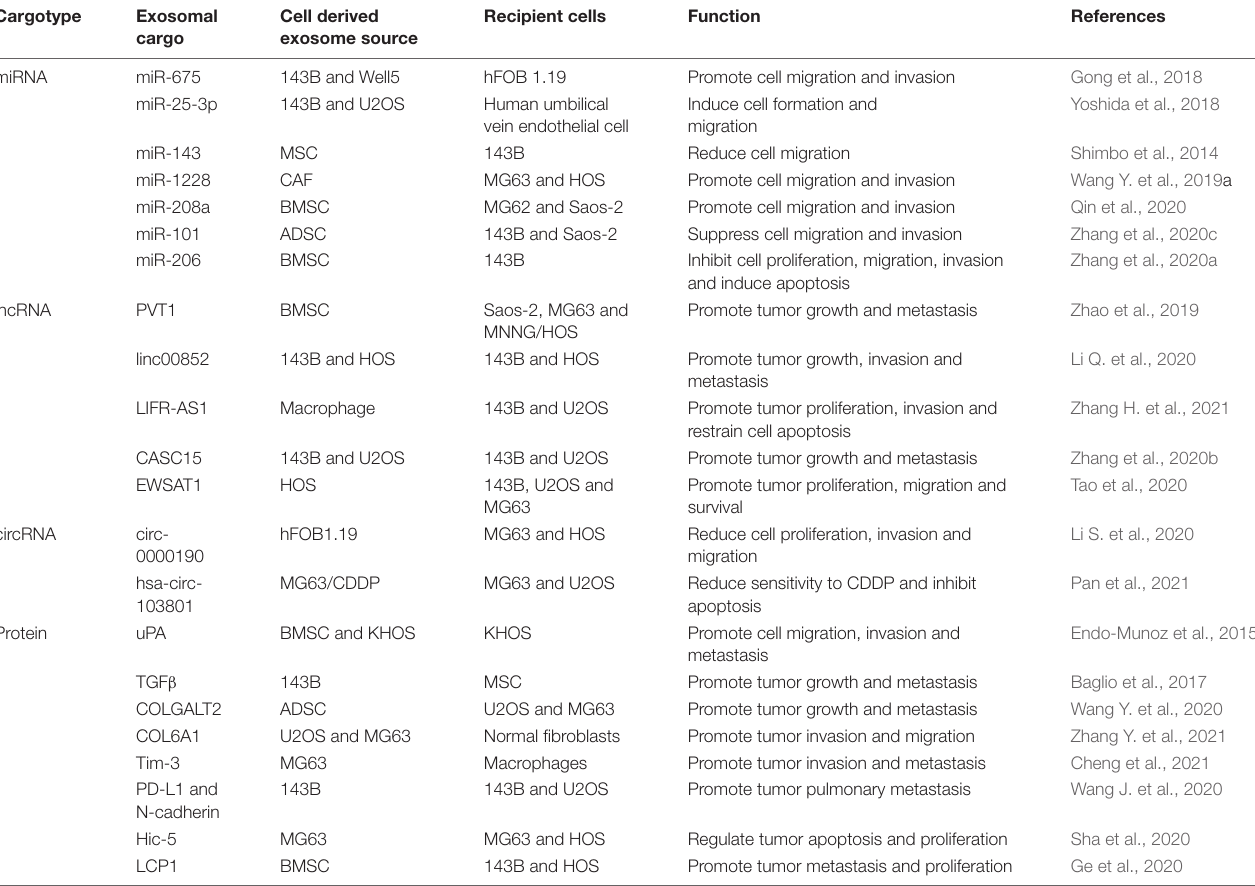
TABLE 1 | Overview of exosomal cargoes and functions in